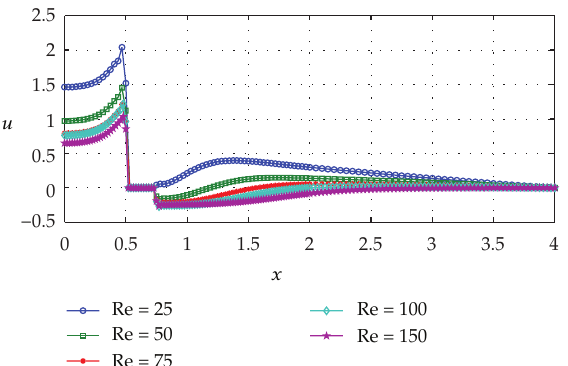
Figure 6: Comparison of pressure along horizontal lines through geometric center of flow